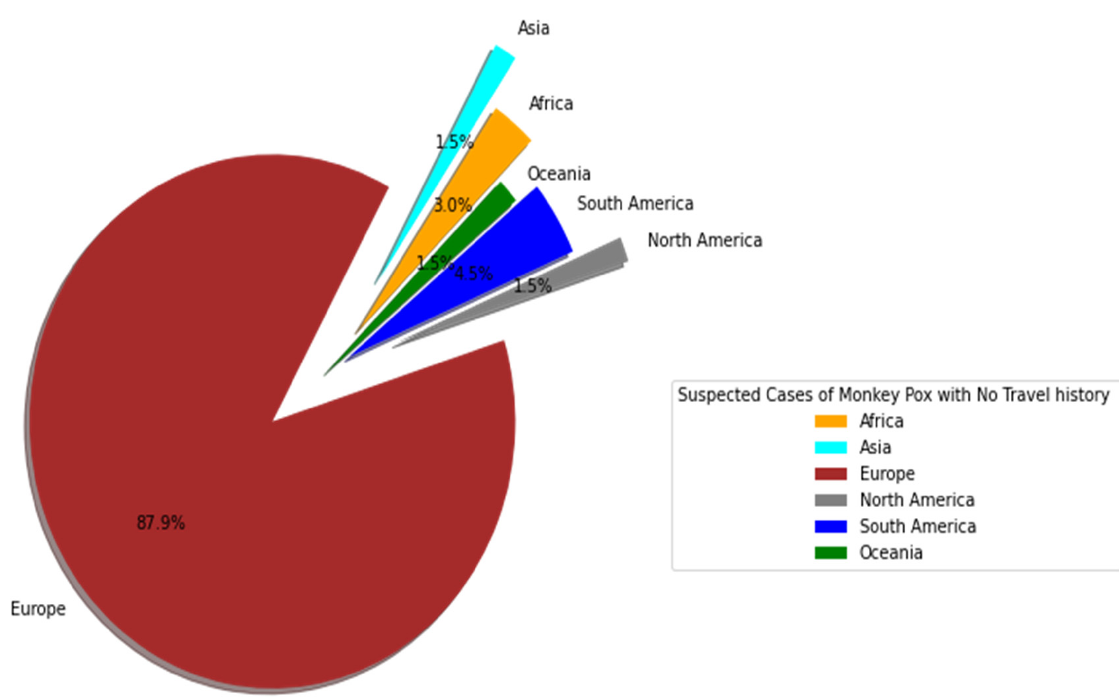
Figure 5. Suspected Travel History of Monkey Pox.